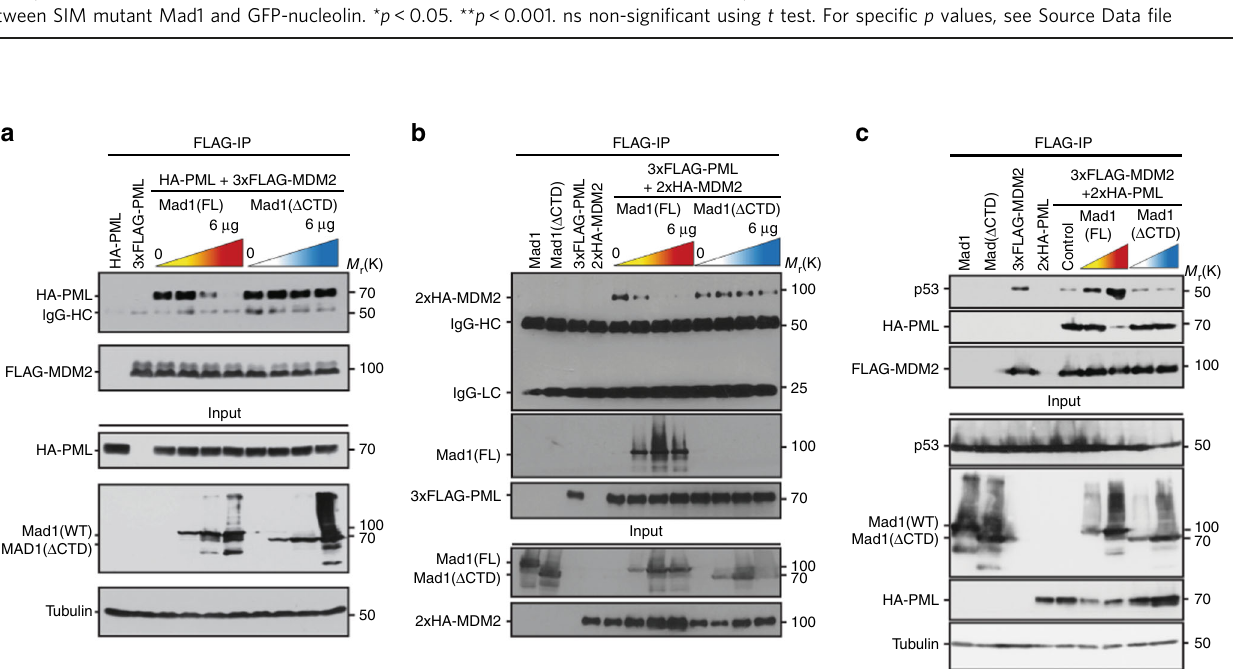
three independent experiments. e , f HeLa cells stably expressing tet-inducible Mad1(SIM mutant)-3xFLAG were incubated with adenovirus expressing nucleolin-mNeonGreen-P2A-mScarlet-MDM2 for 1 h and then cultured with tet for 24 h and doxorubicin for another 8 h. e Immuno fl uorescence showing MDM2 localization to nucleoli after doxorubicin was unaffected by expression of SIM mutant Mad1. f Quanti fi cation of the percentage of cells (±SD) exhibiting nucleolar MDM2 in ( c ). n > 200 cells from each of three independent experiments. g , h HeLa cells stably expressing tet-inducible SIM mutant Mad1 were incubated with adenovirus expressing mNeonGreen-nucleolin for 1 h and then cultured for 24 h in the presence of tet and an additional 8 h ± 2 µ g/mL doxorubicin. g SIM mutant Mad1 does not colocalize with nucleoli. Scale bar, 5 µ m. h Rotated views of ( g ), showing the lack of colocalization between SIM mutant Mad1 and GFP-nucleolin. * p < 0.05. ** p < 0.001. ns non-signi fi cant using t test. For speci fi c p values, see Source Data fi le